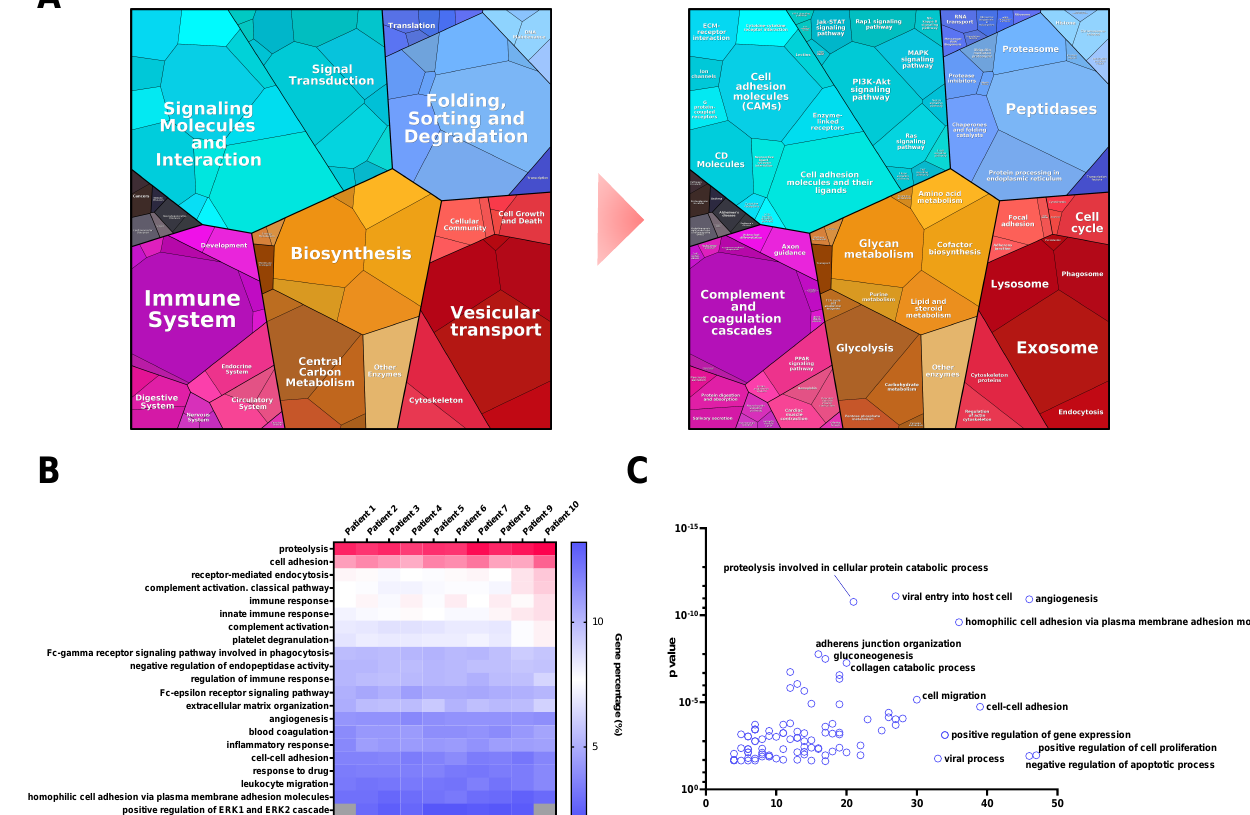
Figure 6. Plasma proteome characterization of MM patients. ( A ) Plasma proteomap based on KEGG pathway enrichment. The analysis covered 57.8% of the MM plasma proteome. The results are grouped into 6 main groups. Light blue: Environmental information processing. Dark blue: Genetic information processing. Pink: Organismal system. Orange: Metabolism. Red: Cellular processes. Black: Human diseases. ( B ) Comparative analysis of the biological processes identified in the undepleted plasma of 10 MM patients using a custom database and MS1t strategy. This analysis was performed using the DAVID functional annotation tool, considering the results with p -value and FDR < 0.05. ( C ) Biological processes specifically enriched in 10 MM patients using MS1t (at least 50% of the patients). This analysis was performed using the DAVID functional annotation tool, considering the results with p -value and FDR < 0.05 .